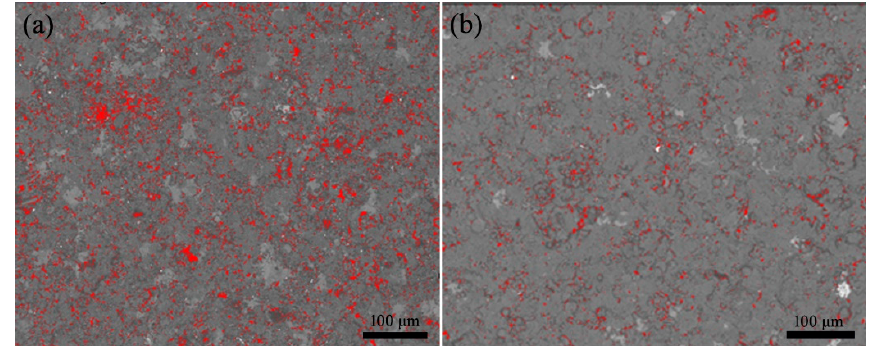
Figure 5. Image J calculated porosity of the AT13 coatings prepared at ( a ) nonoptimized parameters and ( b ) optimized parameters.